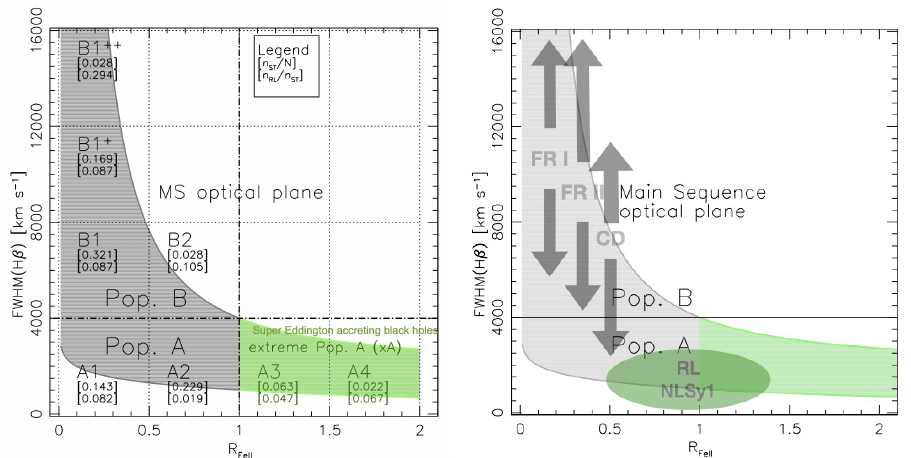
Figure 1. Left : Sketch of the optical plane of the MS, FWHM H β vs. R FeII . Numbers in square brackets provide, from top to bottom, the full sample fractional occupation, the fraction of RL (CD + FR-II) sources in each spectral bin. Right : Same section of the optical plane, but with a rough indication of the FWHM domain spanned by FR-I, FR-II, and CD along with the location of the RL NLSy1 galaxies considered in this study (dark green area).